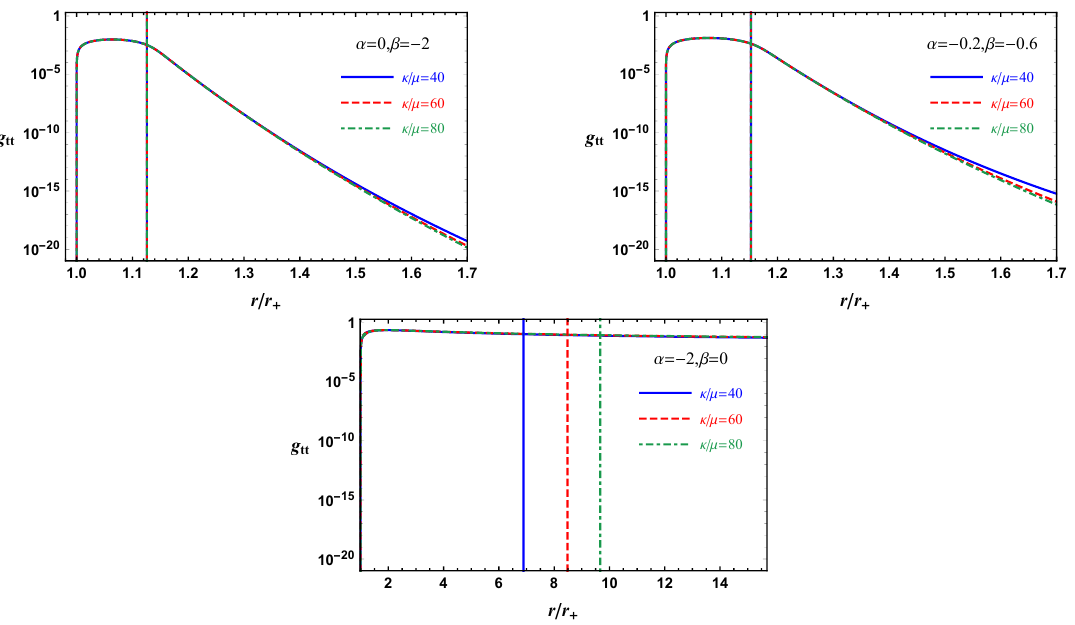
Figure 15 . The metric component g tt as a function of r near the would-be inner horizon (the vertical dashed lines) for large values of κ/µ . Here we take T/T c = 0 . 995